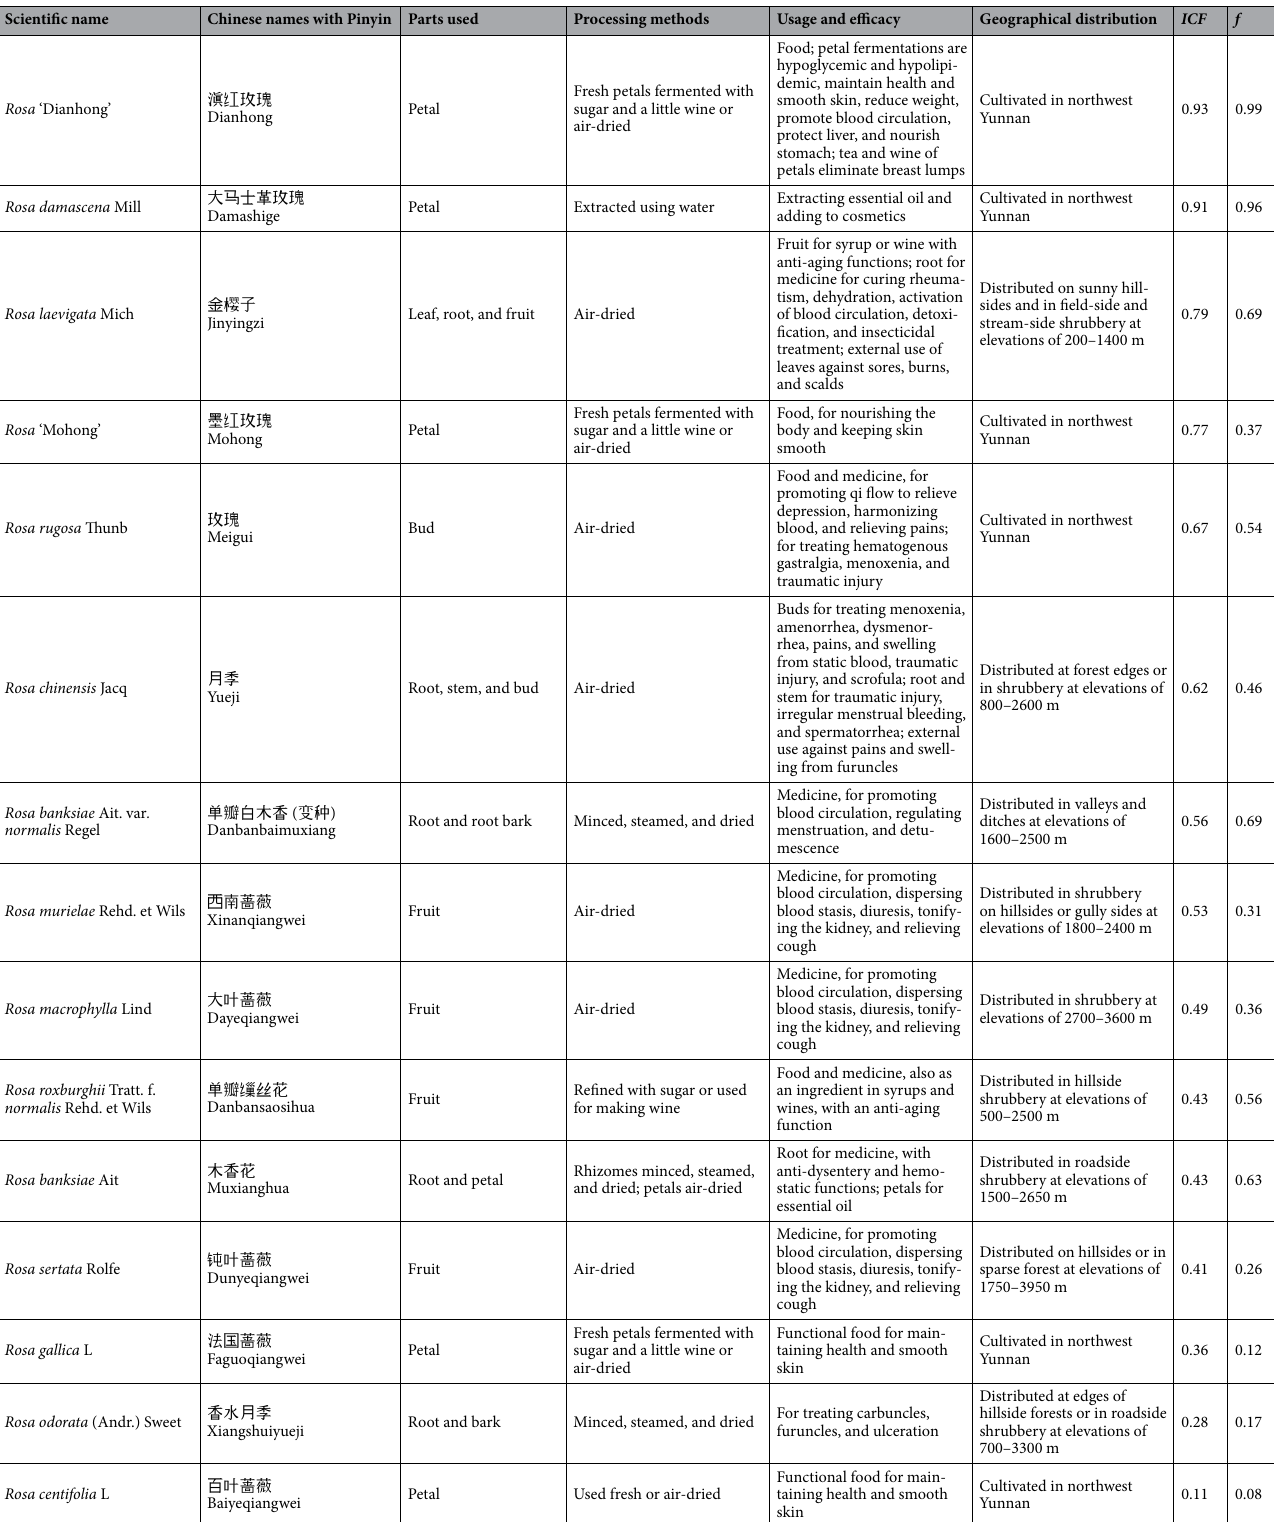
Table 1. Summary of traditional applications of the genus Rosa in Dali Bai